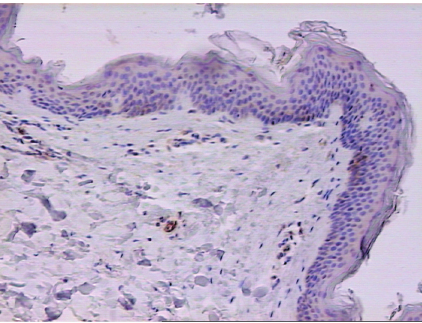
Figure 3: Lack of expression of TF. Healthy skin. 100x. Immunohis- tochemistry.